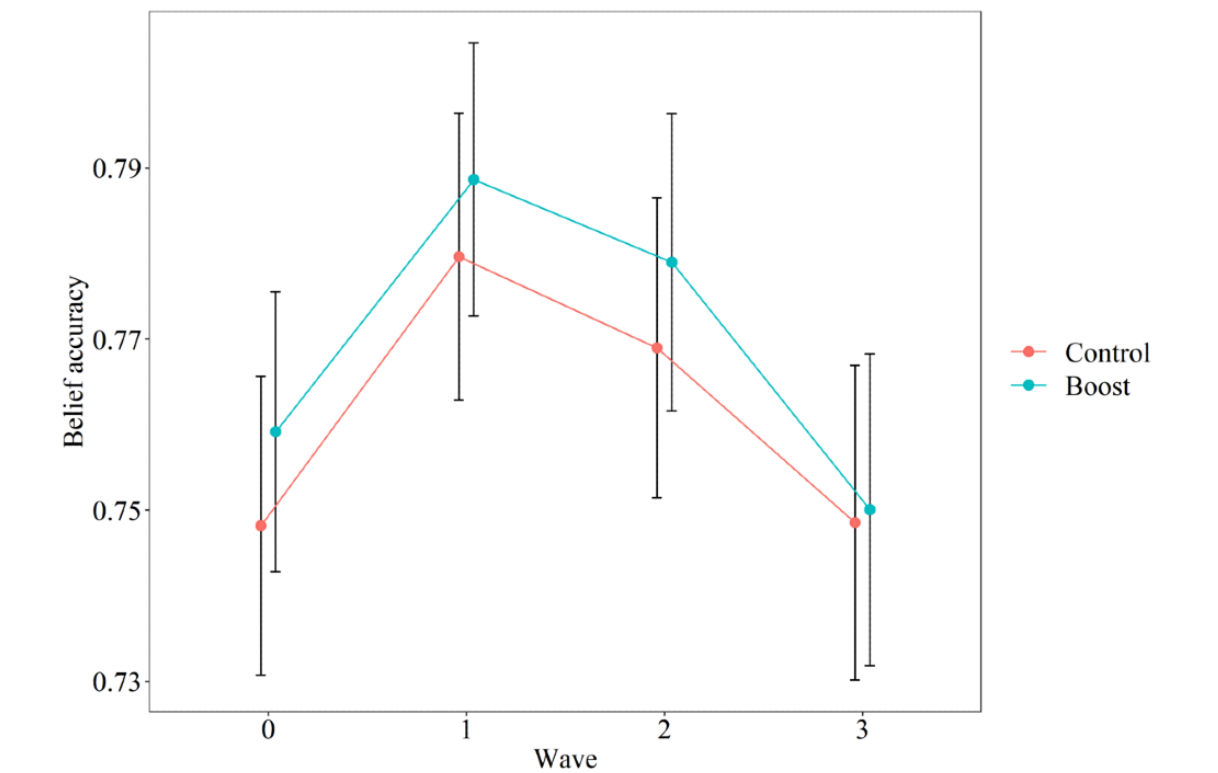
Figure 5. Belief accuracy per condition over time. Error bars indicate 95% CI focusing on the comparison between experimental conditions, not adjusted for within-subject variability. The belief accuracy scale ranged from –1, indicating completely inaccurate beliefs, to 1, indicating completely accurate